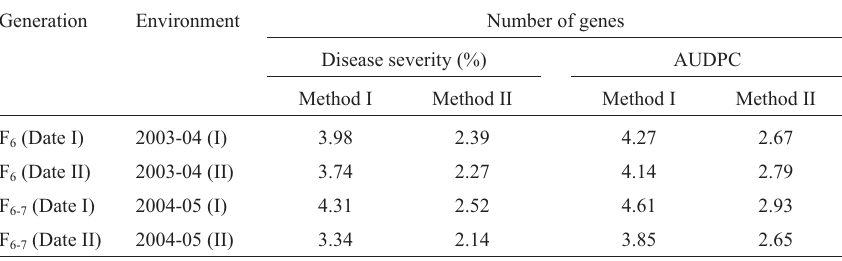
Table 4 - Estimate of maximum number of effective genes contributing to spot blotch resistance in crosses between IBON18 x RD 2508 using Wright’s (1968) formula modified for F 6 generation (Singh et al. , 1995) in four environments. Generation